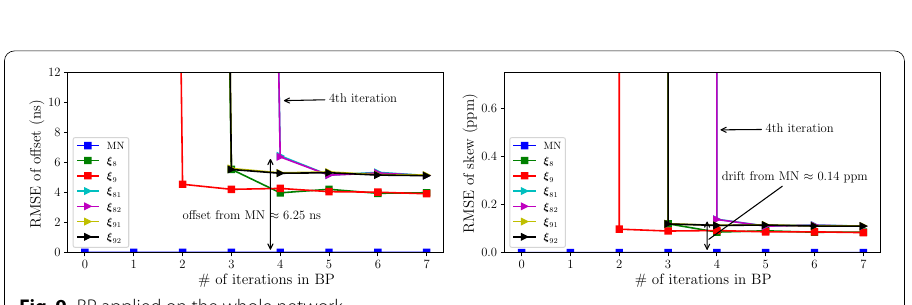
Fig. 9 BP applied on the whole network